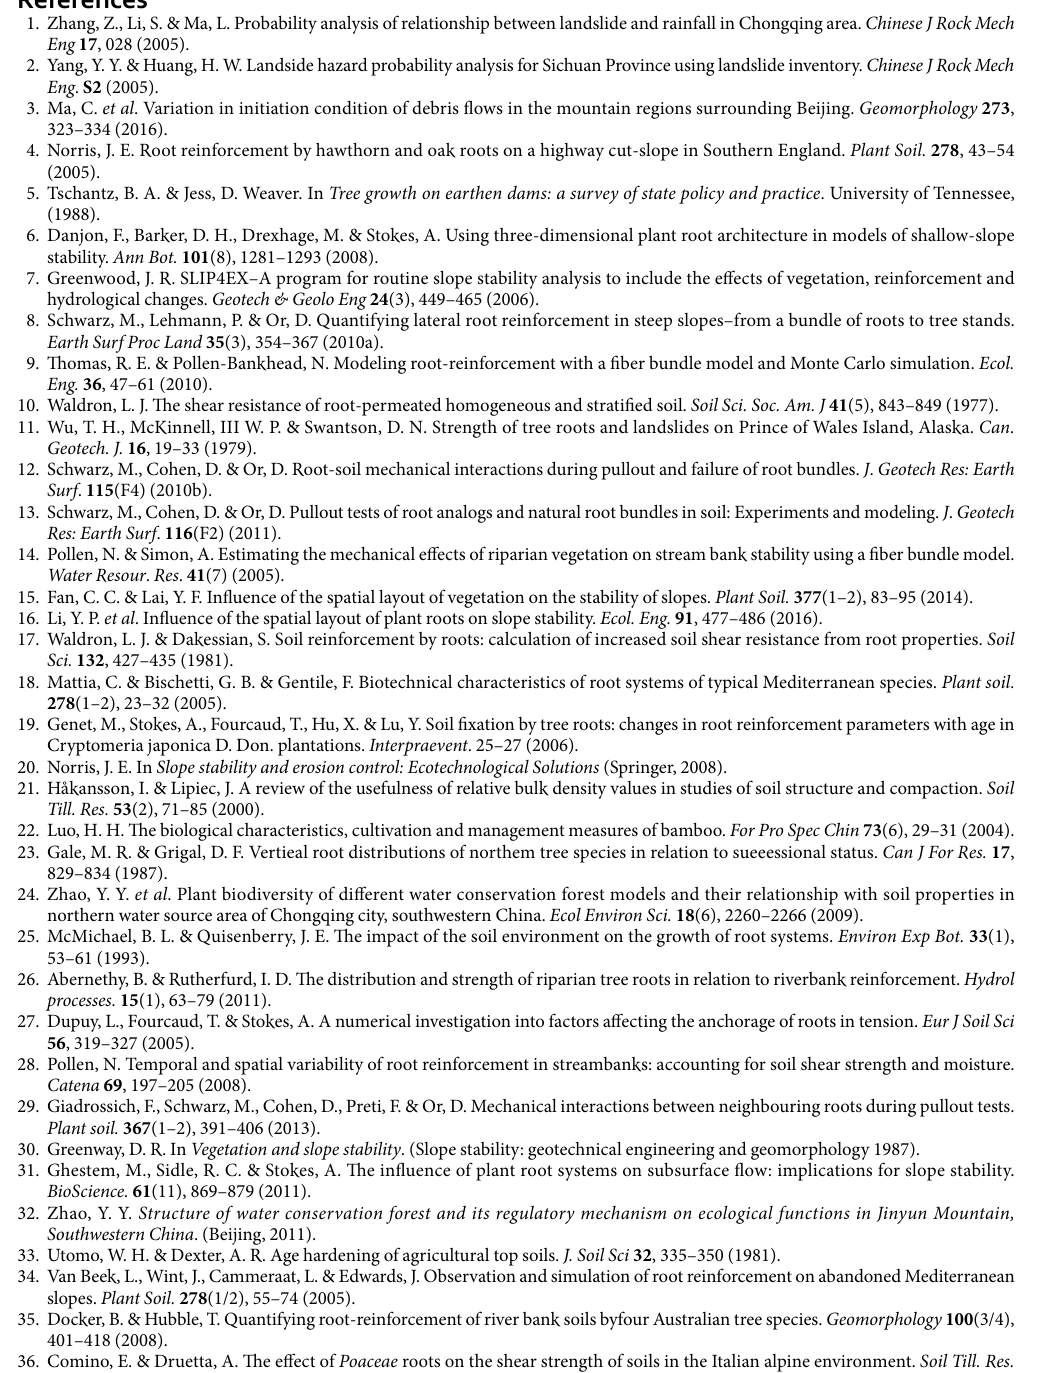
simulated as a weight of 20 KN in the vertical direction. Six trees were planted on slope separated by horizontal distance of 1 m. Slope gradients ( θ ) were 15°, 30° and 45°. The horizontal length of the slope was 6 m ensuring that the horizontal distance between trees was constant. Cohesive force and friction angle tested by the triaxial tests could be divided into two groups: total c and φ , effective cohesive force c ′ and soil friction angle φ ′ . The total c and φ represented the soil indexes of the soil-root blocks. The c ′ and φ ′ were soil indexes without roots. We assumed that the influence of roots on soil shear strength beyond the CATM extended to 1 m (Fig. 7b). All the calculations were completed using a program from Lizheng Software (Tianjin, China). Methods of Janbu 44 and Bishop 45 were used to calculate the slope safety